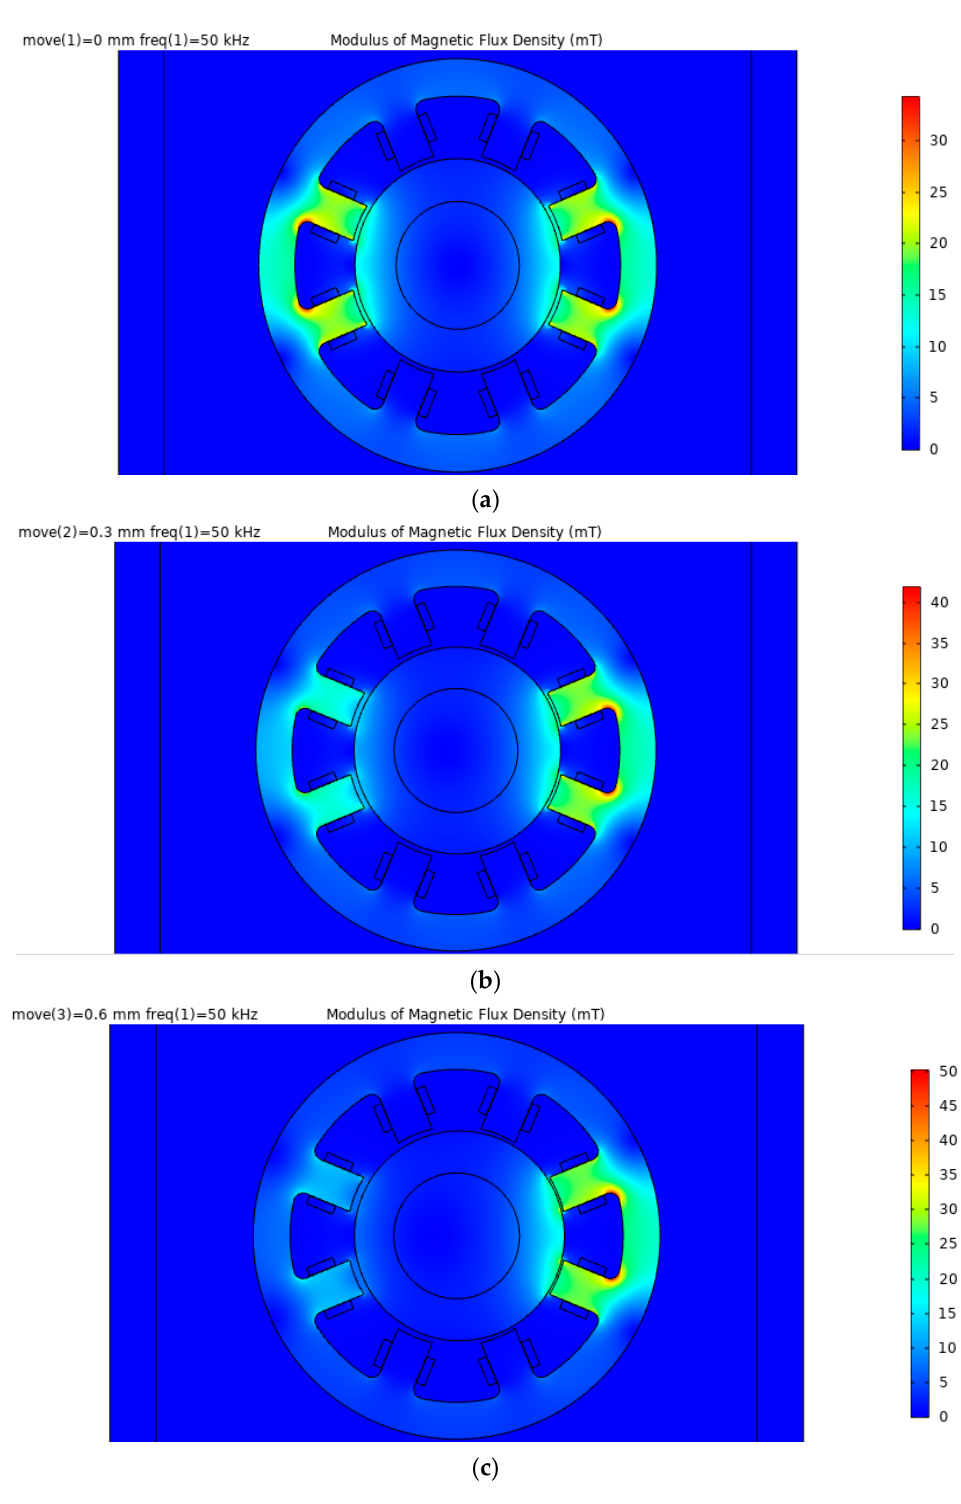
Figure 13. Simulation distribution diagrams of the magnetic flux density modulus of the sensor. ( a